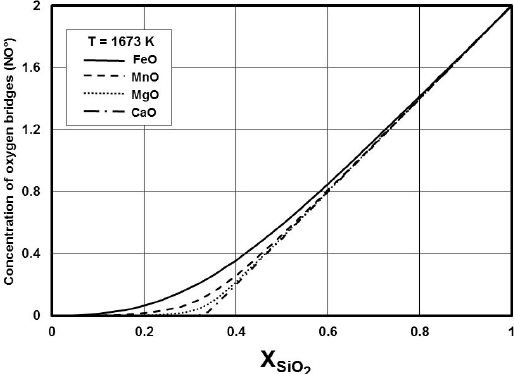
Figure 1. Concentration of oxygen bridges in the SiO (M = Fe, Mn, Mg, Ca) system calculated at 1673 K by the structural